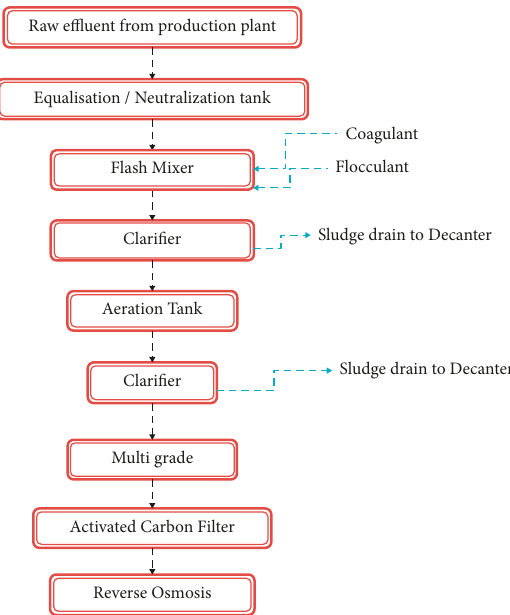
Figure 2: Conventional treatment method.